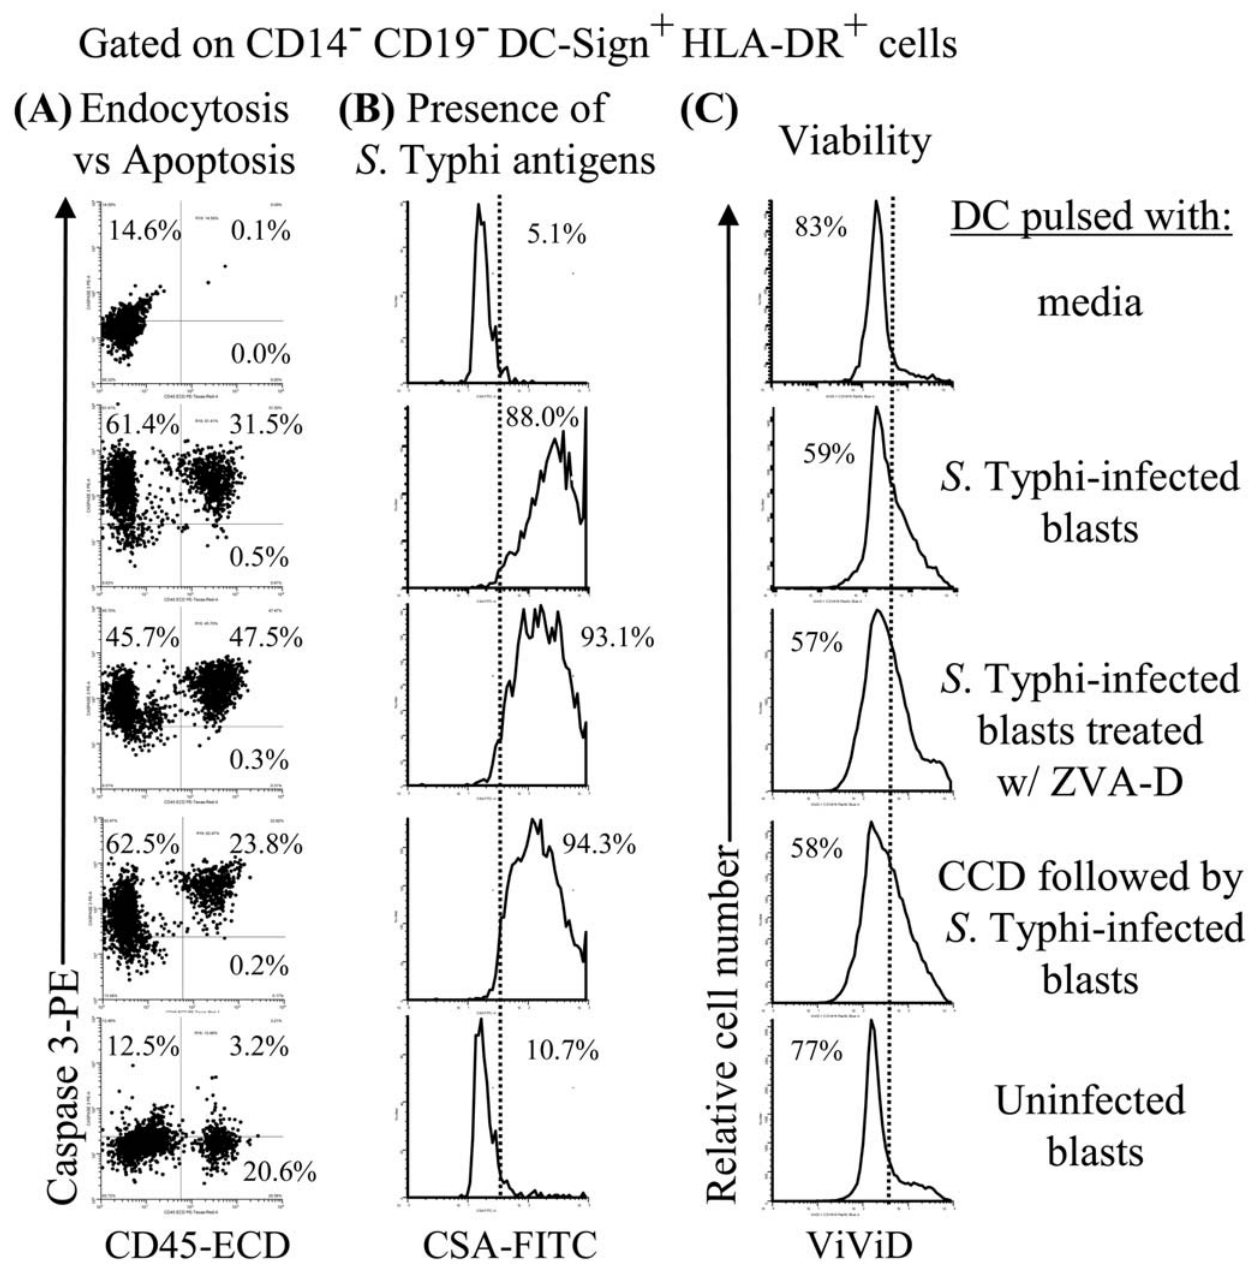
Figure 4. DC efficiently uptake S. Typhi-infected blasts. DC from volunteer CVD4000 # 64 treated or not with ZVA-D or CCD agents were incubated with uninfected or S. Typhi-infected CD45-labeled blasts at a DC:blast ratio of 1:5 at 37 u C. After 2 hours of incubation, DC were stained with ViViD, followed by surface staining with mAbs to HLA-DR, DC-Sign, Salmonella common structural antigens (CSA) and caspase-3 and analysed by flow cytometry. DC were gated based on their scatter characteristics. Single DC were selected by gating on forward scatter height vs. forward scatter area and then on HLA-DR and DC-Sign. ( A ) endocytosis and apoptosis on DC was analyzed by studying expression of CD45 and caspase-3, respectively. (B) The presence of S. Typhi antigens on caspase-3 + cells were analyzed by determining their expression of CSA. ( C ) Viability of DC under different culture conditions was evaluated by ViViD as a dead cell exclusion marker. Dotted lines represent the cut-offs between positive and negative cells. Numbers correspond to the percentage of positive cells in the indicated quadrants or regions in each histogram. These results are representative of 1 of 3 volunteers with similar results. Additional data is provided in Fig. 5.